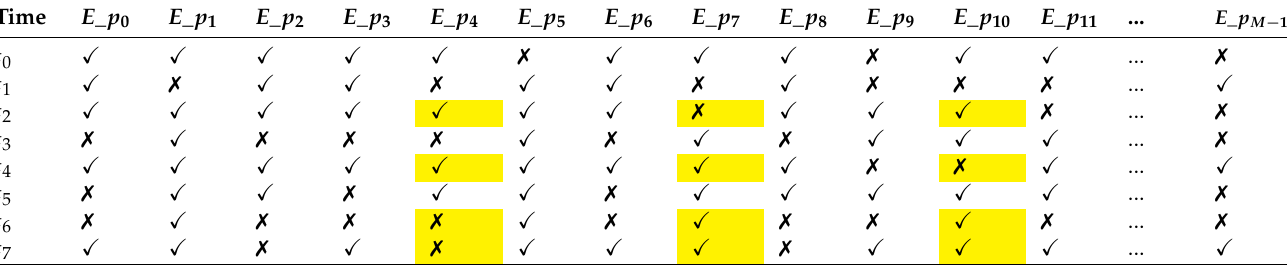
Table 2. Querying in archive A Sat with values of time and E returned by M pixels obtained from the satellite images. The yellow-colored cells represent the measurements of satellite pixels, which are returned as the result of the